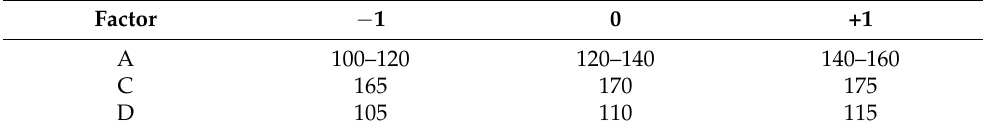
Table 5. Levels of different process variables in coded and uncoded form for biodesulfurization. Factor